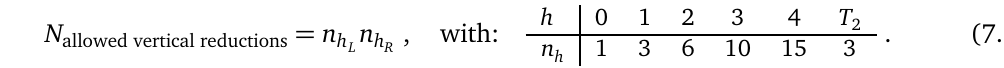
Figure 28: SL ( 2, (cid:90) ) -transformed diagrams whose vertical reduction involves “ T gauging.” They have 9, 18 and 9 allowed vertical reductions,